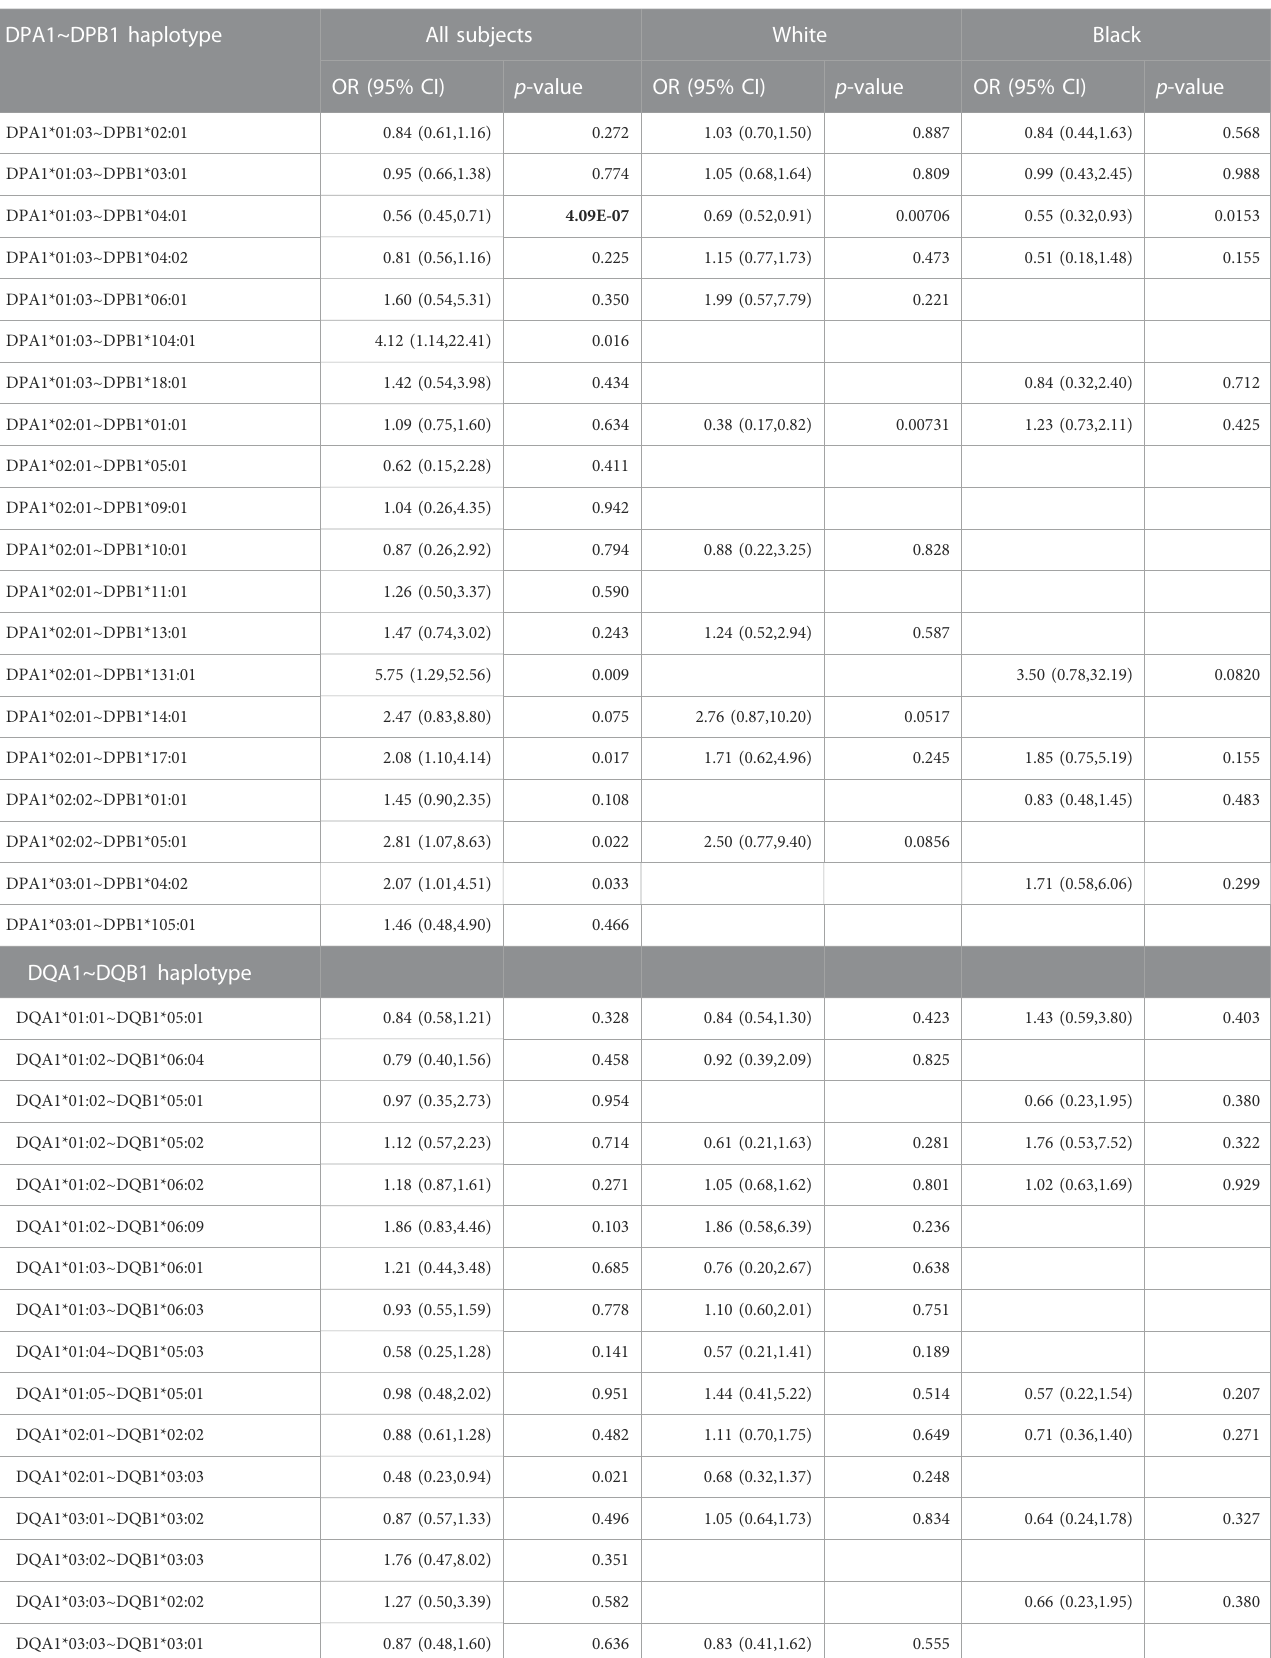
TABLE3HaplotypesfortheentiredatasetforHLAmoleculeswithalphaandbetachainssequenced.CorrectionfactorforDPA1~DPB1is20( p < 0.0025),DQA1~DQB1is 24 ( p < 0.00208). Signi fi cant p -values are